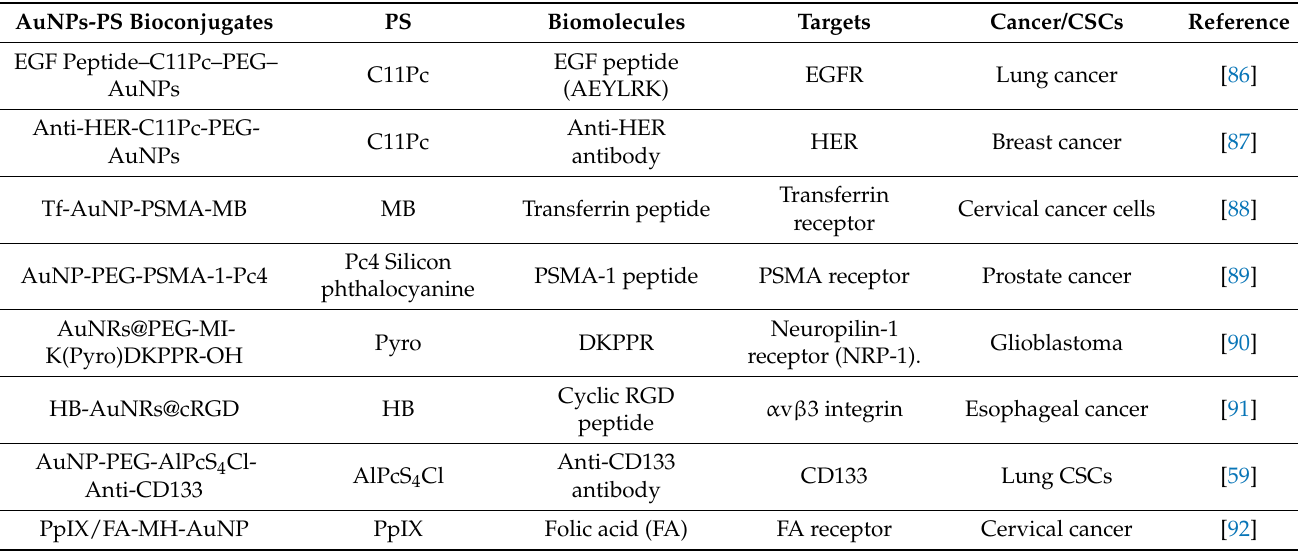
Table 2. Gold Nanoparticle Bioconjugates Actively Targeting biomarkers of Cancer and Cancer Stem